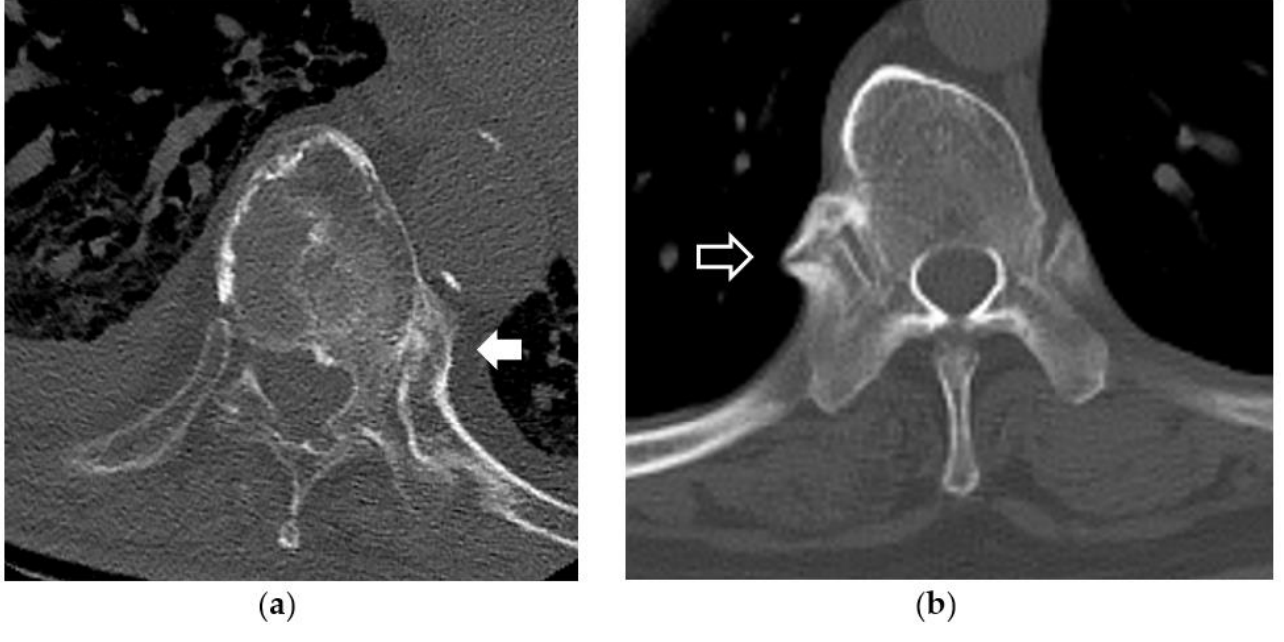
Figure 2. Evaluation of hyperostosis around the costovertebral joint. The cross-sectional CT image passing through the costovertebral joint from T1 vertebra to the T12 vertebra was used to evaluate the hyperostosis around the costovertebral joint. ( a ) There is ankylosis and excrescence in the left costovertebral joint (white arrow). ( b ) There is bone bridging in the right costovertebral joint (black arrow).